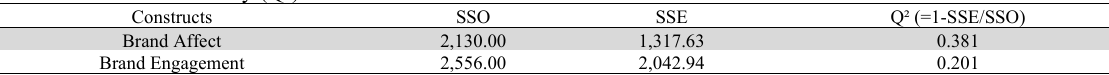
Cross-Validated Redundancy (Q 2